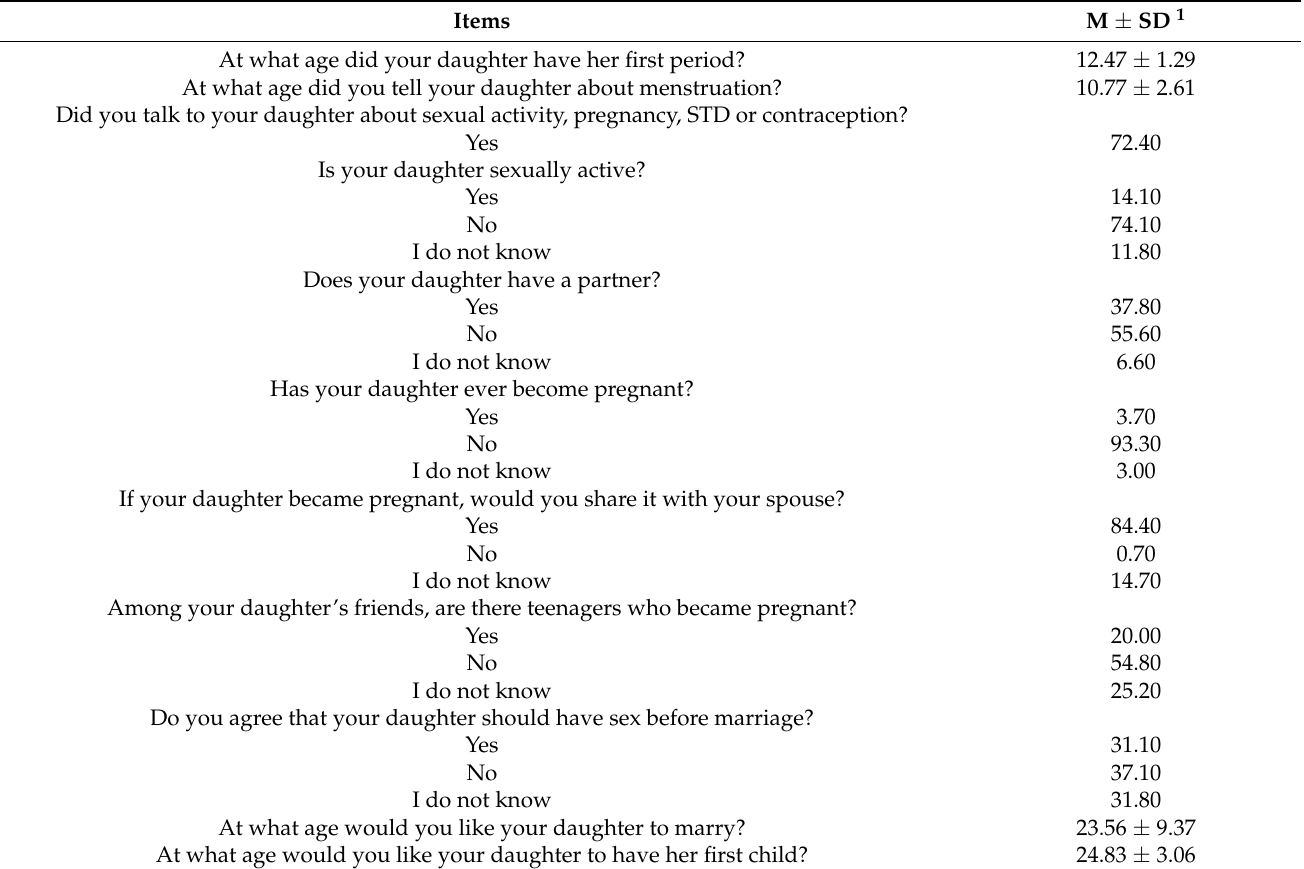
Table 3. Items focusing on mothers’ level of knowledge about their daughters’ sexuality and sexual activity. Items M ± SD 1 At what age did your daughter have her first